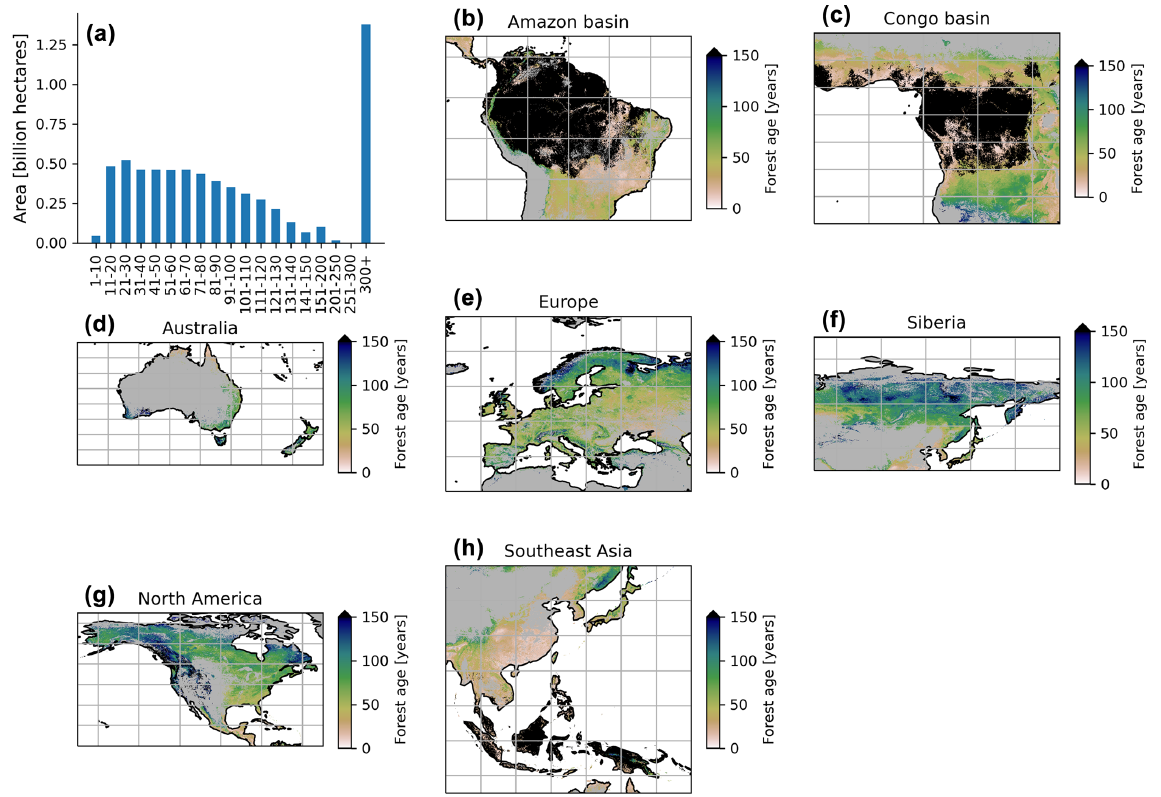
Figure 6. Total area of each age class globally (a) and close-up examples in the Amazon basin (b) , Congo basin (c) , Australia (d) , Europe (e) , Siberia (f) , North America (g) and Southeast Asia (h) . The forest age estimates in the close-up examples (b–h) range from 0 to 150 years old for a better visualization. The forest age map using a 10% tree cover threshold is